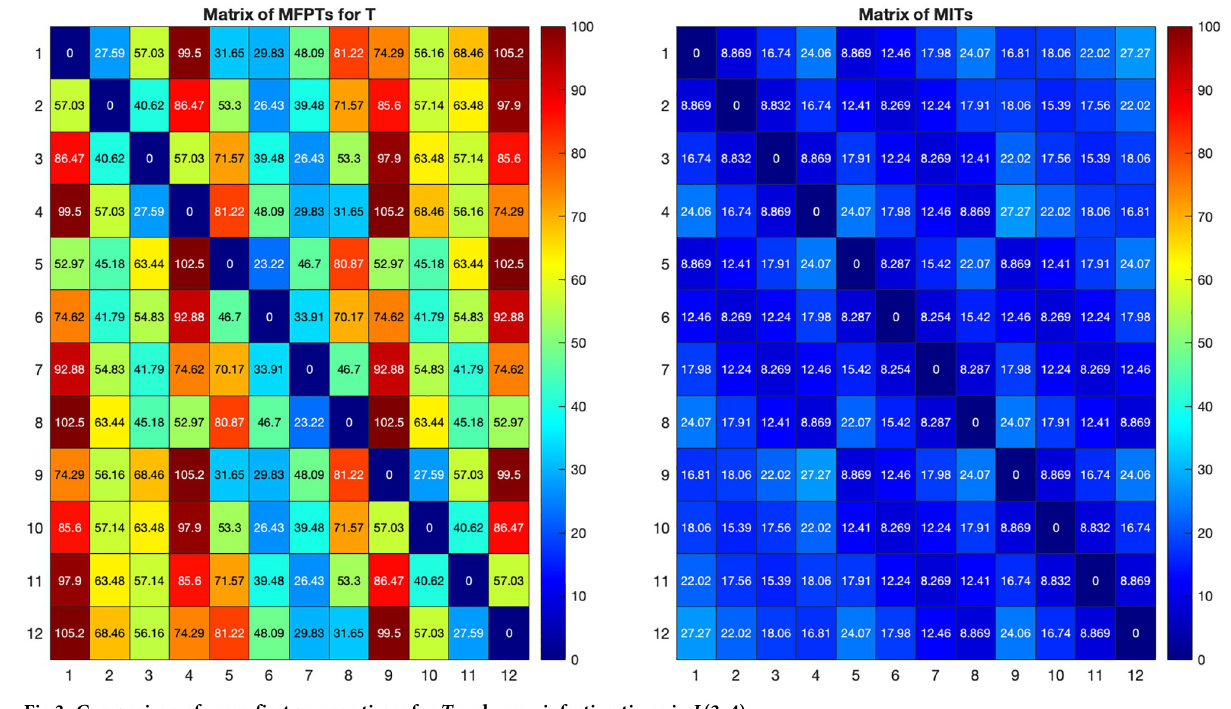
Fig 3. Comparison of mean first passage times for T and mean infection times in L (3,